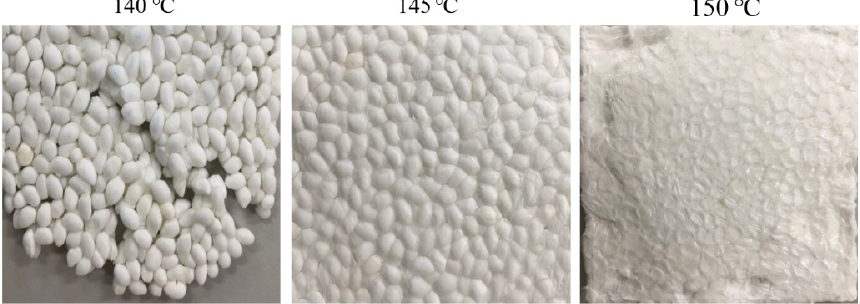
Figure 4. Effect of molding temperature in the compression molding of ETPU beads at 3.5 MPa for 15 min.